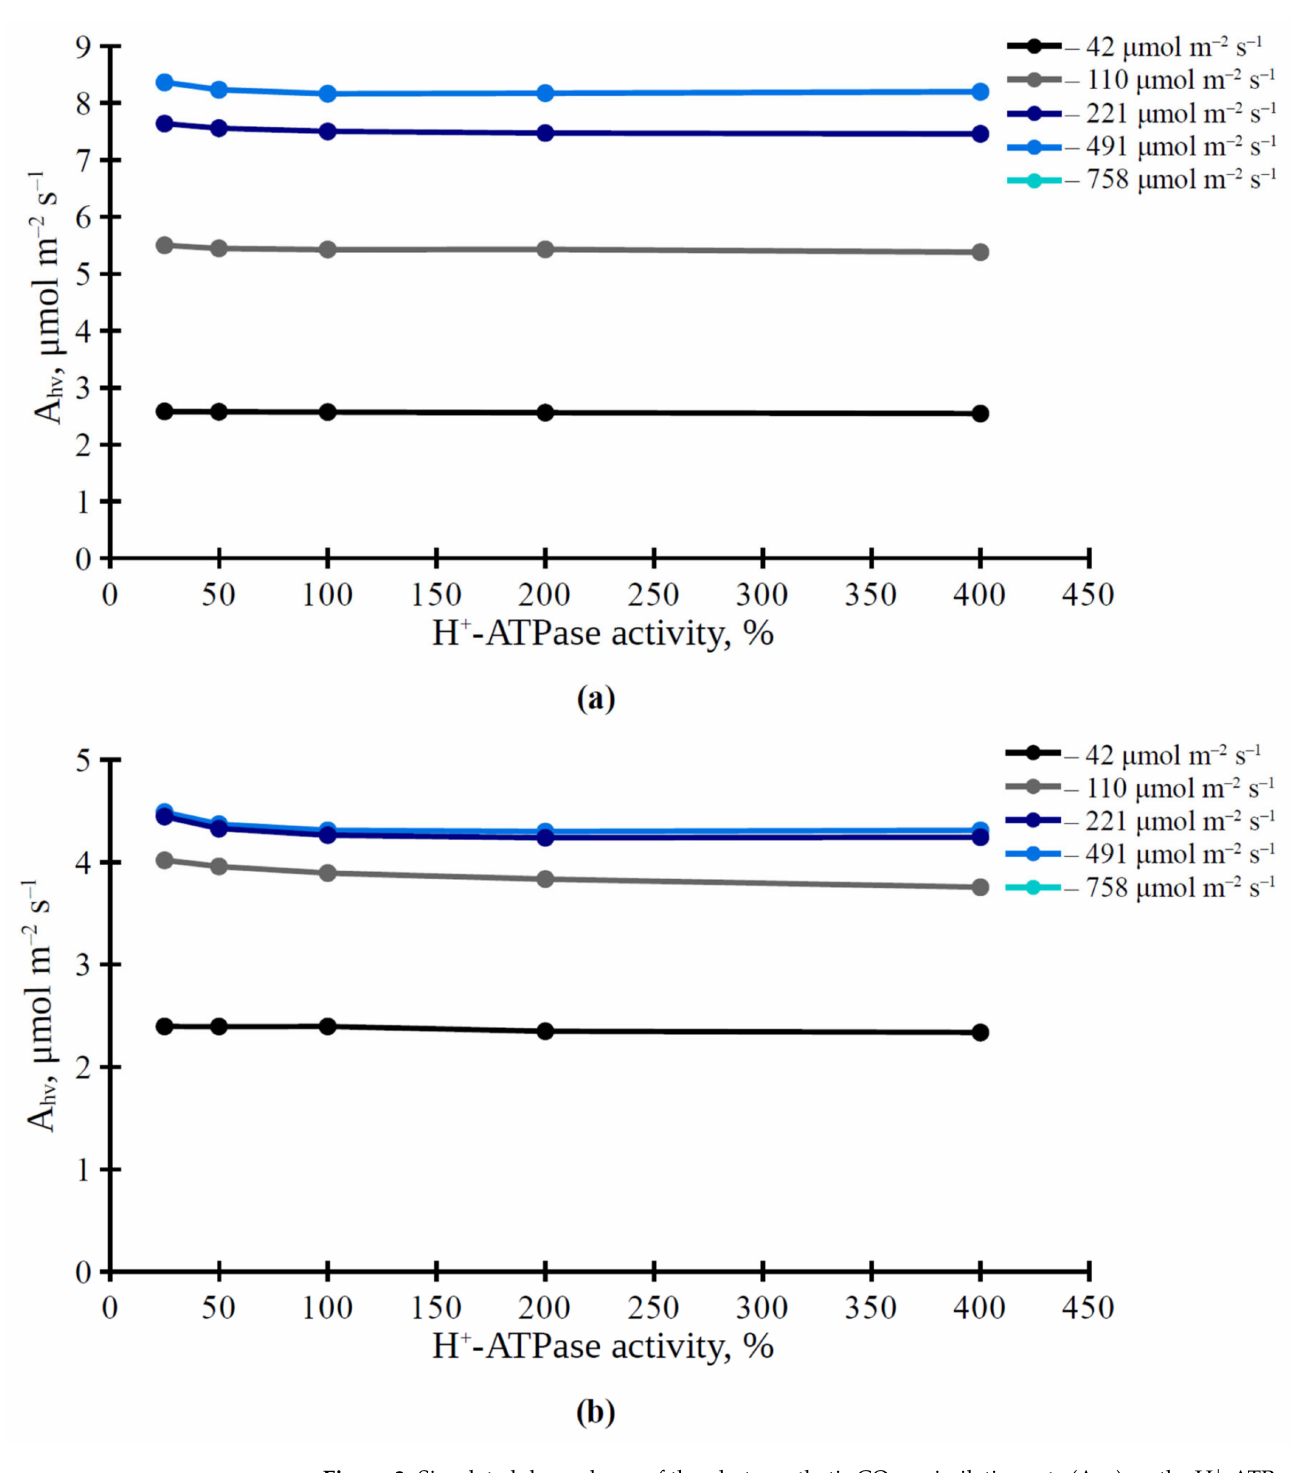
Figure 3. Simulated dependence of the photosynthetic CO 2 assimilation rate (A hv ) on the H + -ATPase activity in variants with stomata located in center of the 3 × 3 cell square ( a ) or in center of the 5 × 5 cell square ( b ) under various intensities of PAR. The value of the H + -ATPase activity from our previous work [42] was used as